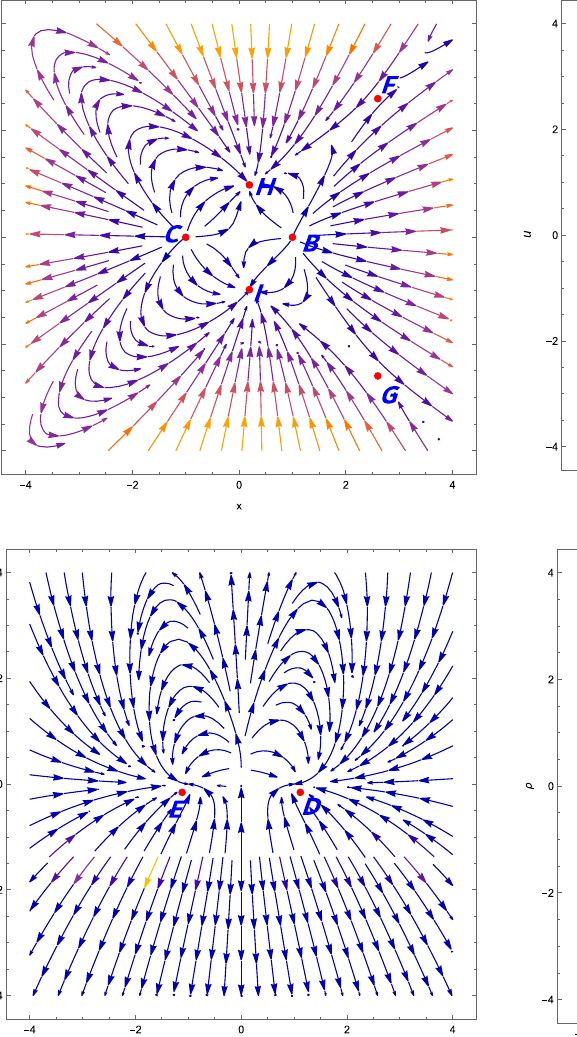
, the lower right 2